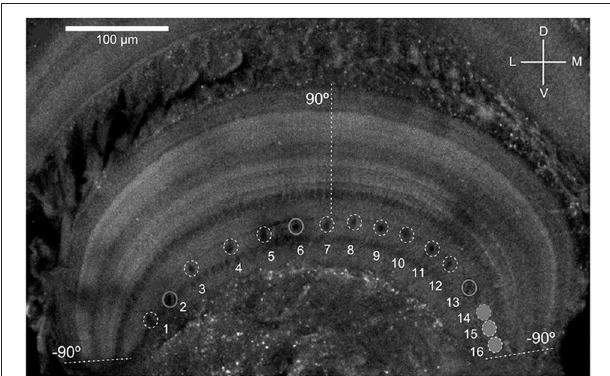
FIGURE 1 | Distribution of the main dendritic profiles of the 16 MLG1s across the transversal lobula axis (see Medan et al., 2015 for details). Dashed lines indicate region of the lobula where the lateral visual pole of the eye (90 ◦ ) and the medial visual pole ( − 90 ◦ ). D, Dorsal; V, ventral; L, lateral; M,